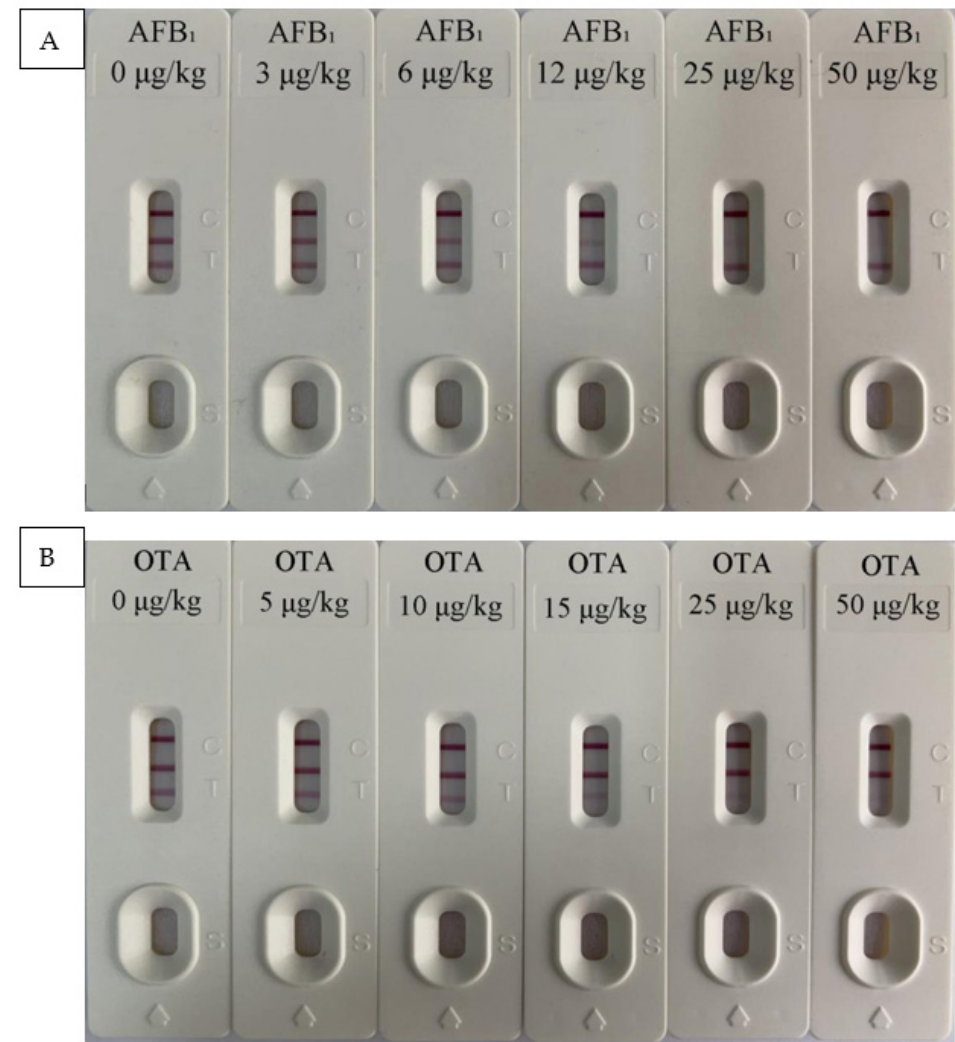
Figure 2. ( A ) aflatoxin B 1 (AFB 1 ) and ( B ) ochratoxin A (OTA) test strip quantitative detection limit determination. Table 2. Detection limit of test strip.